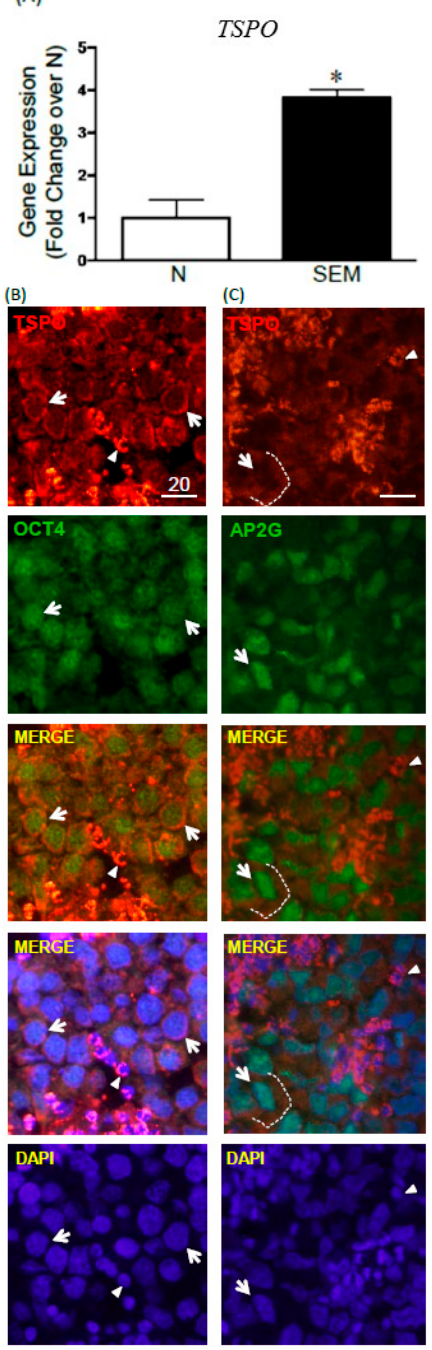
Figure 5. TSPO mRNA and protein expression in human seminomas. ( A ) TSPO mRNA expression in normal human adult testicular tissue and seminoma biopsies. n = 3–4, * p -value < 0.05; ( B ) TSPO ( red ) and OCT4 ( green ) protein expression in seminomas, visualized by IF in sections from Patient 4. Blue: DAPI nuclear staining. Representative images are shown; ( C ) TSPO ( red ) and AP2 γ ( green ) protein expression in seminomas examined by IF in Patient 6. Representative images shown. ( B , C ) Arrows indicate representative seminoma cells; arrowheads indicate TSPO-positive small somatic cells (likely Leydig cells). Scale bars in Figure 4B,C are 20 μ m.